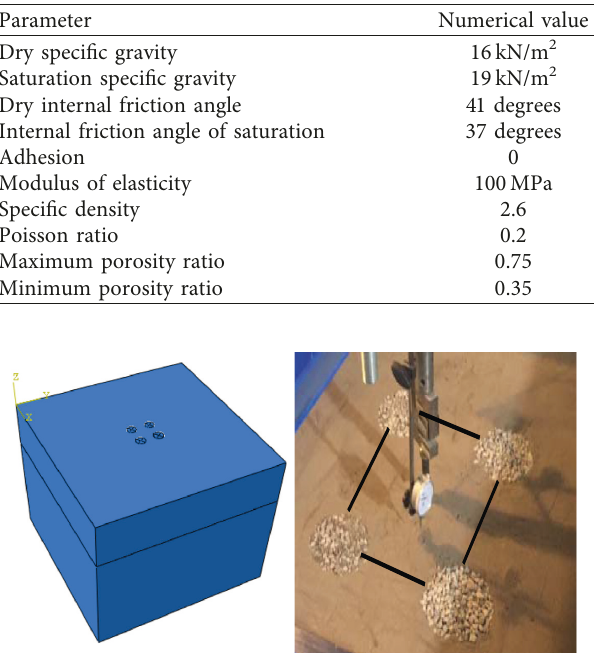
Figure 6: Sandy soil model reinforced with 4 stone pillars.